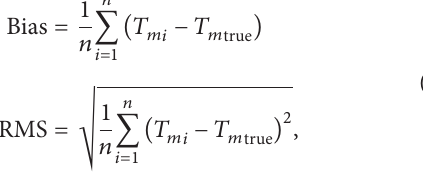
used to establish multifactor RTMs, and the 𝑇 𝑚 resulting from the radiosonde in the period 2013-2014 were used to assess the performance of the new